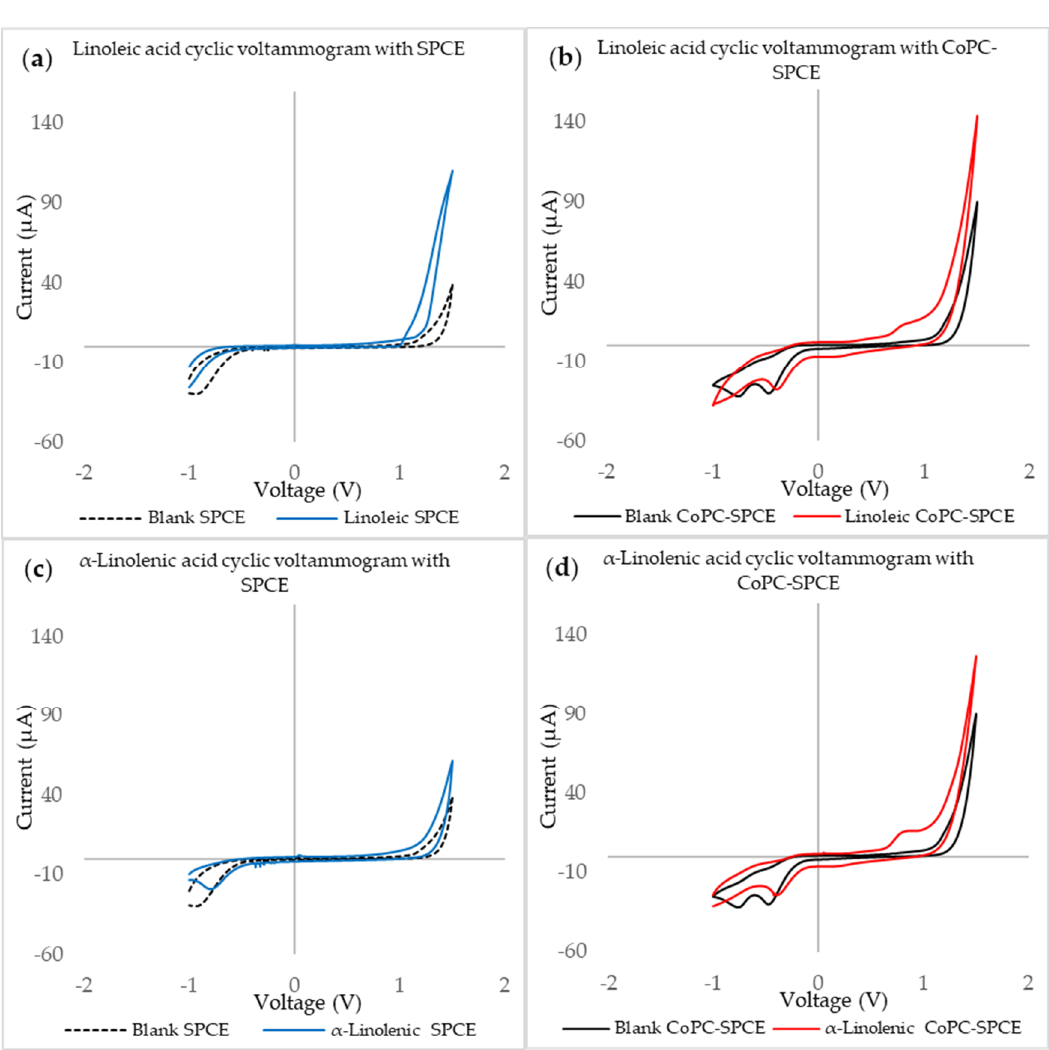
Figure 1. Cyclic voltammograms obtained for: ( a ) linoleic acid using a plain SPCE with LOX (blue), and blank buffer solution (dashed black); ( b ) linoleic acid using a CoPC-SPCE with LOX (red), and blank buffer solution (black); ( c ) α-linolenic acid using a plain SPCE with LOX (blue) and a blank buffer solution (dashed black); ( d ) α-linolenic acid using a CoPC-SPCE with LOX (red), and a blank buffer solution (black). SPCE = screen-printed carbon electrode; CoPC = cobalt phthalocyanine; LOX = lipoxygenase.